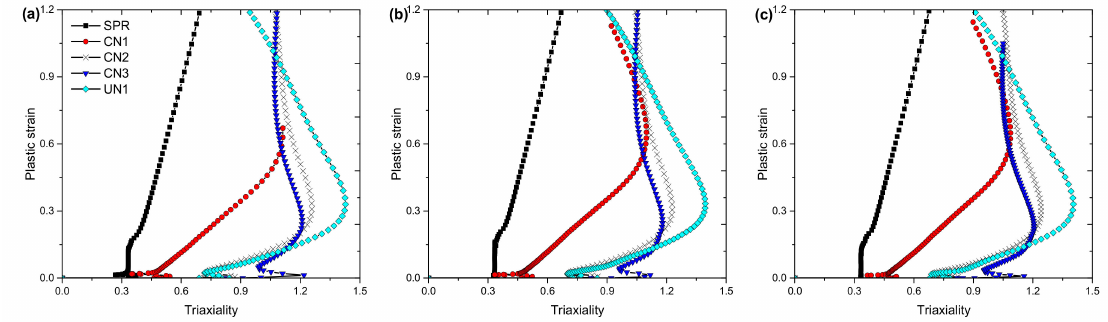
Figure 6. Stress triaxiality vs. plastic strain at the center of the cross-section for test specimens, ( a ) RT, ( b ) 500 ◦ C-AC, and ( c ) 500 ◦